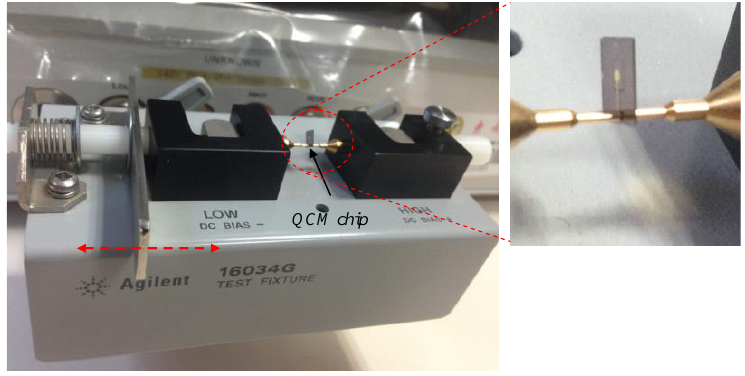
Figure 3. Measurement apparatus with a 16034G test fixture.